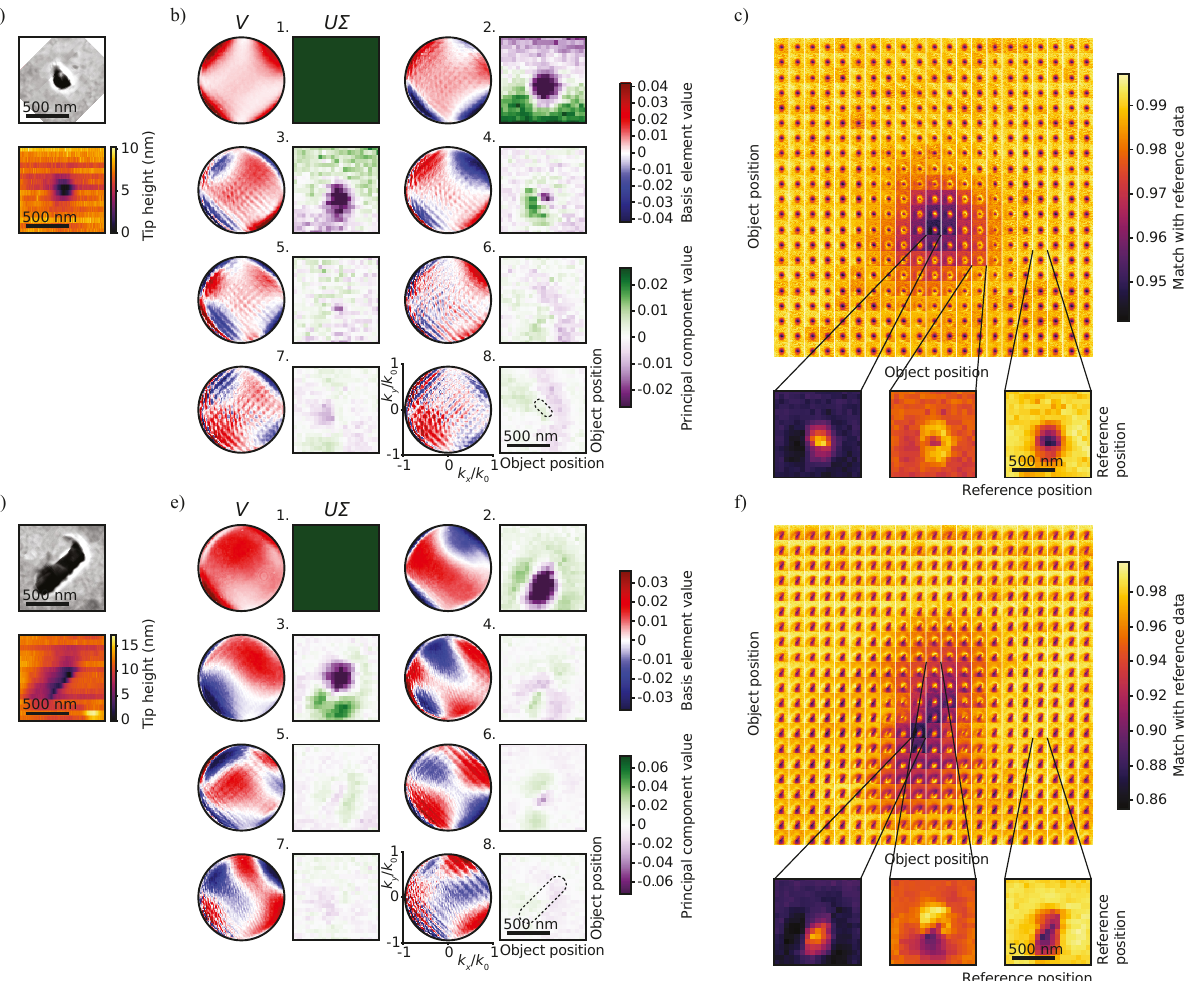
Figure 3: Measured dependence of the radiation pattern on the object position for a (a–c) small aperture and (d–f) large aperture. (a and d) SEM image (top) and shear-force topography scan (bottom) of the transducer. (b and e) Singular value decomposition of a set of reference data for 21 × 21 probe points covering an area of 1 × 1 μ m in 50 nm steps. Shown are the first eight principal component directions V (blue–red), forming a radiation pattern basis, and matching principal components U Σ (purple–green), representing the importance at each object position. (c and f) Match of signal data with reference data. Each of the images in the 21 × 21 grid shows the match of a newly acquired radiation pattern at this position with all positions of the reference data set. Three positions are highlighted